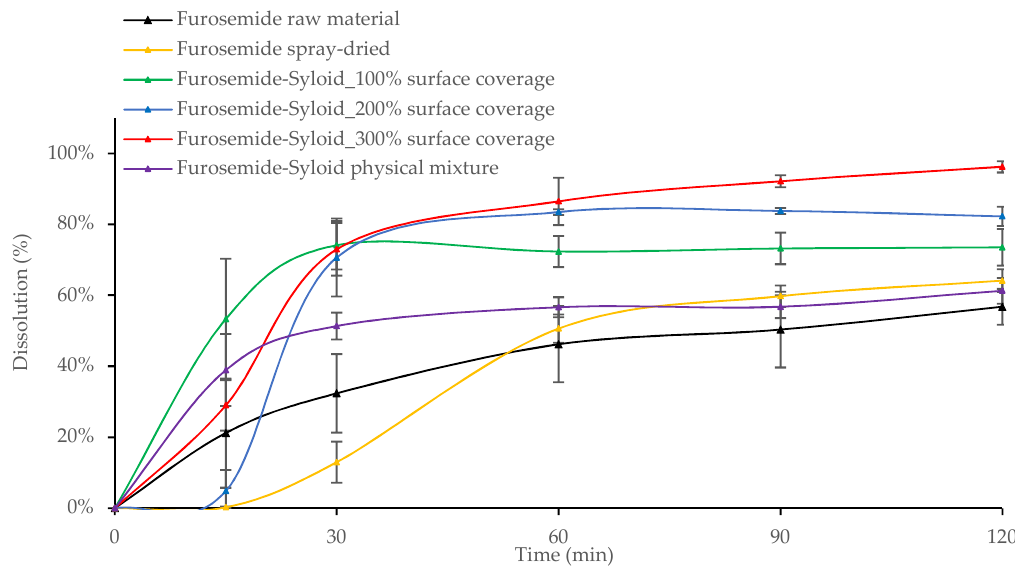
Figure 7. Release profiles of Furosemide raw and spray-dried materials, Furosemide-Syloid formulations at various drug loads, Furosemide-Syloid physical mixture. Testing conditions: HCL-NaCl medium pH 3 + 0.25% sodium lauryl sulfate (SLS), 900 mL, USP apparatus 1, 100 rpm. Medium was adapted from a study carried out by Ambrogi et al. [17] with the addition of SLS to maintain sink condition.